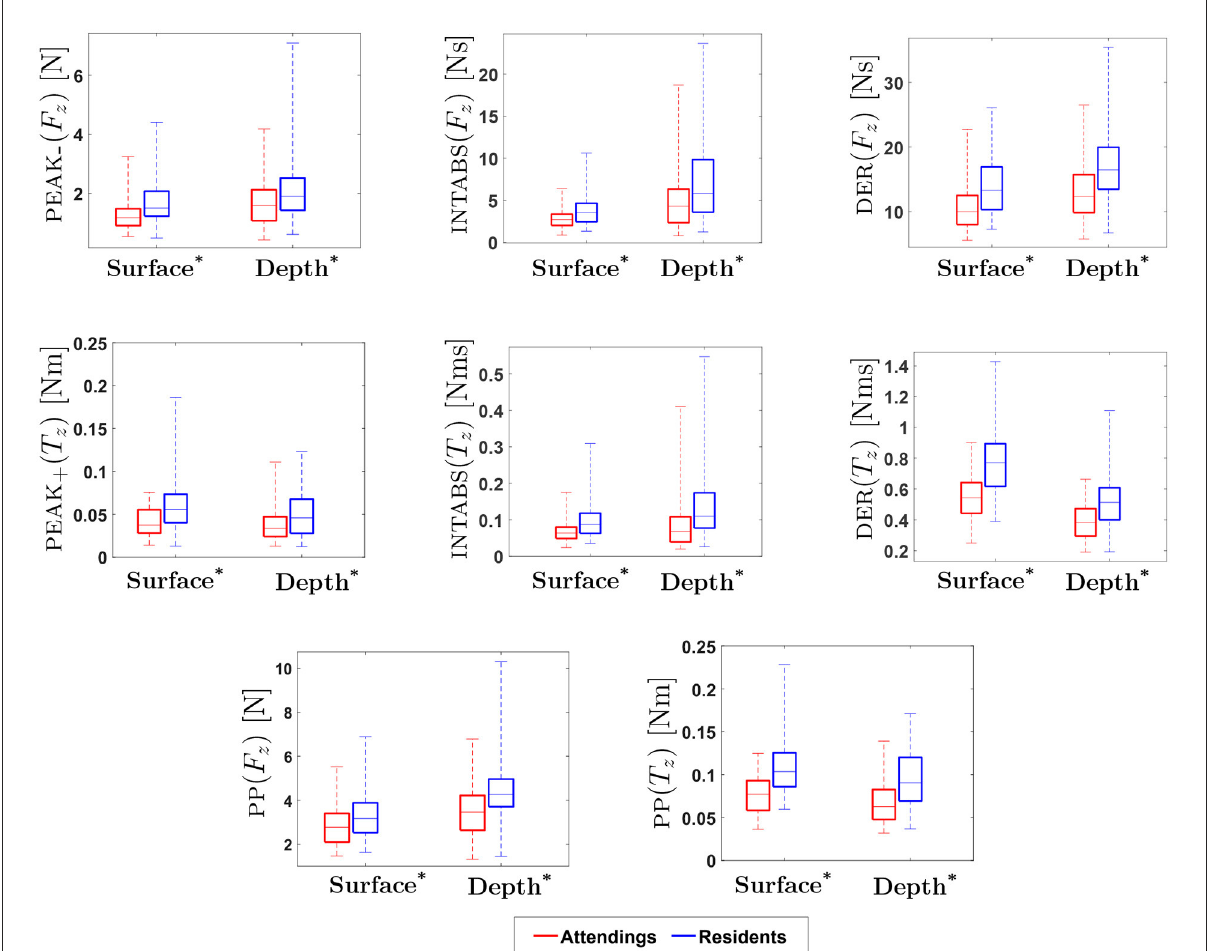
FIGURE8 Experimental Results for Force/Torque-based Metrics: * indicates statistical significance for p < 0.05. (On each box, the middle line indicates the median, and the bottom and top edges of the box indicate the 25 and 75 th percentiles, respectively. The whiskers are extended to the most extreme data points including